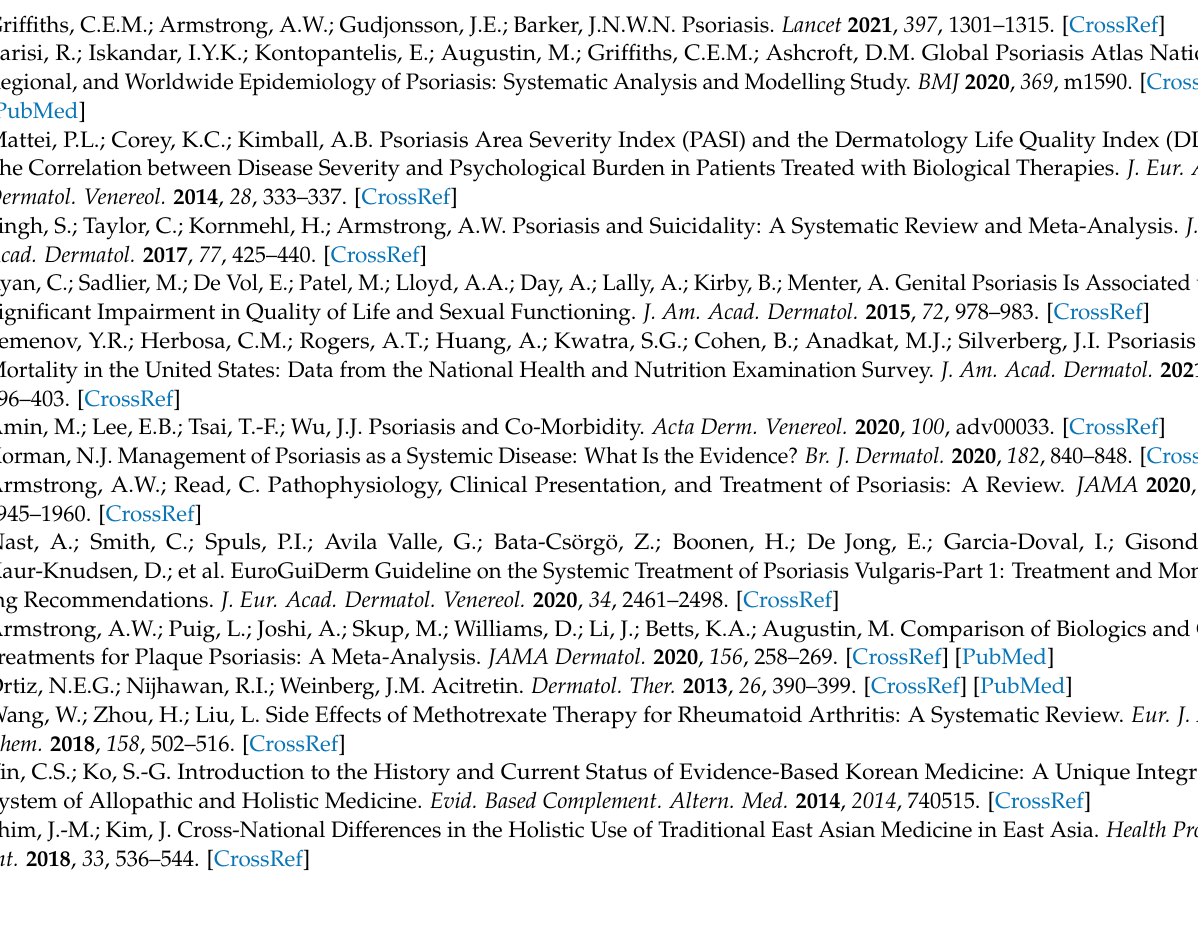
Supplementary Figure S4. Bubble plot of continuous PASI score for source of investigational medicine; Supplementary Figure S5. Bubble plot of continuous PASI score for sample